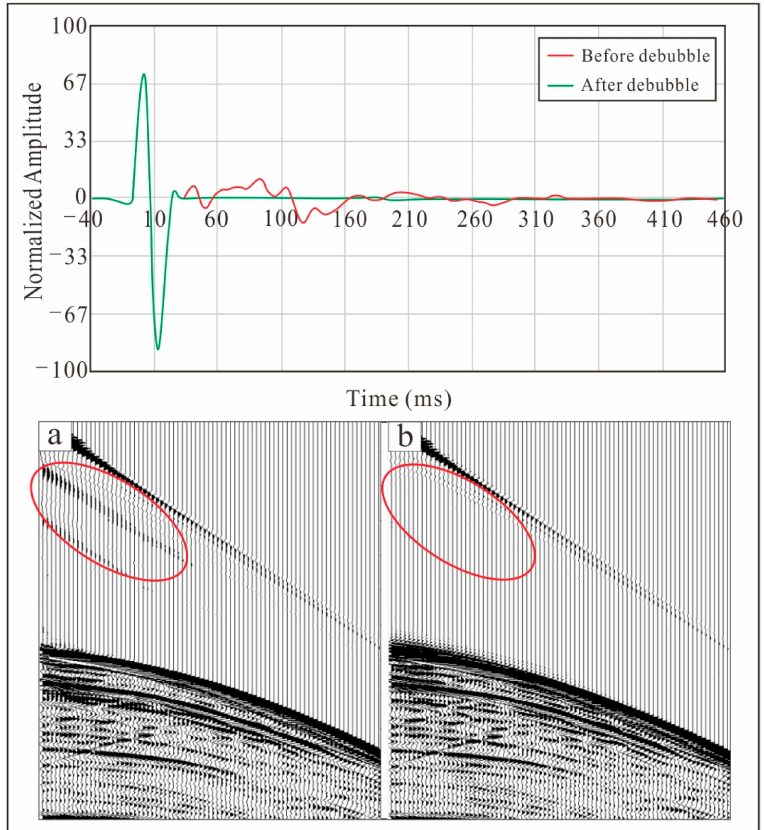
Figure 6. Wavelet ( upper half ) and gathers ( lower half ) comparison before ( a ) and after ( b ) the